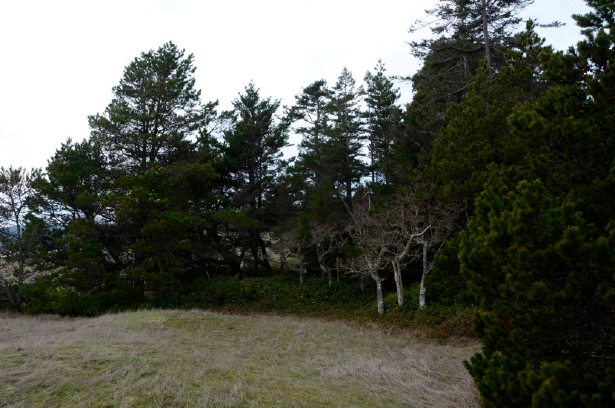
Figure 4. Garry oak trees located at the present-day forest edge are experiencing overhead shading, infilling and subsequent mortalities (likely due to encroaching Douglas-fir and shore pine trees).